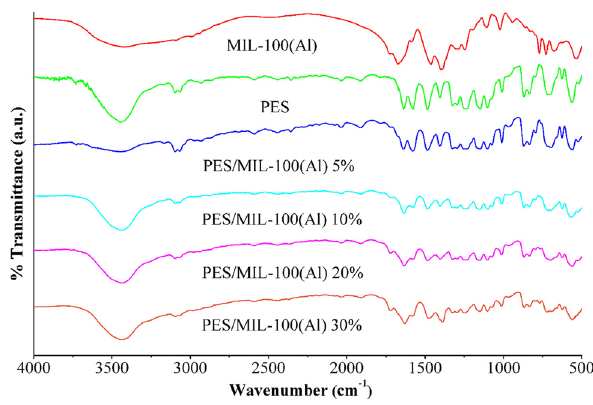
Figure 4: FTIR spectra of MIL - 100 ( Al ) , PES, and MIL - 100 ( Al ) /PES MMMs with several di ff erent percentage additions of MIL - 100 ( Al ) to PES.